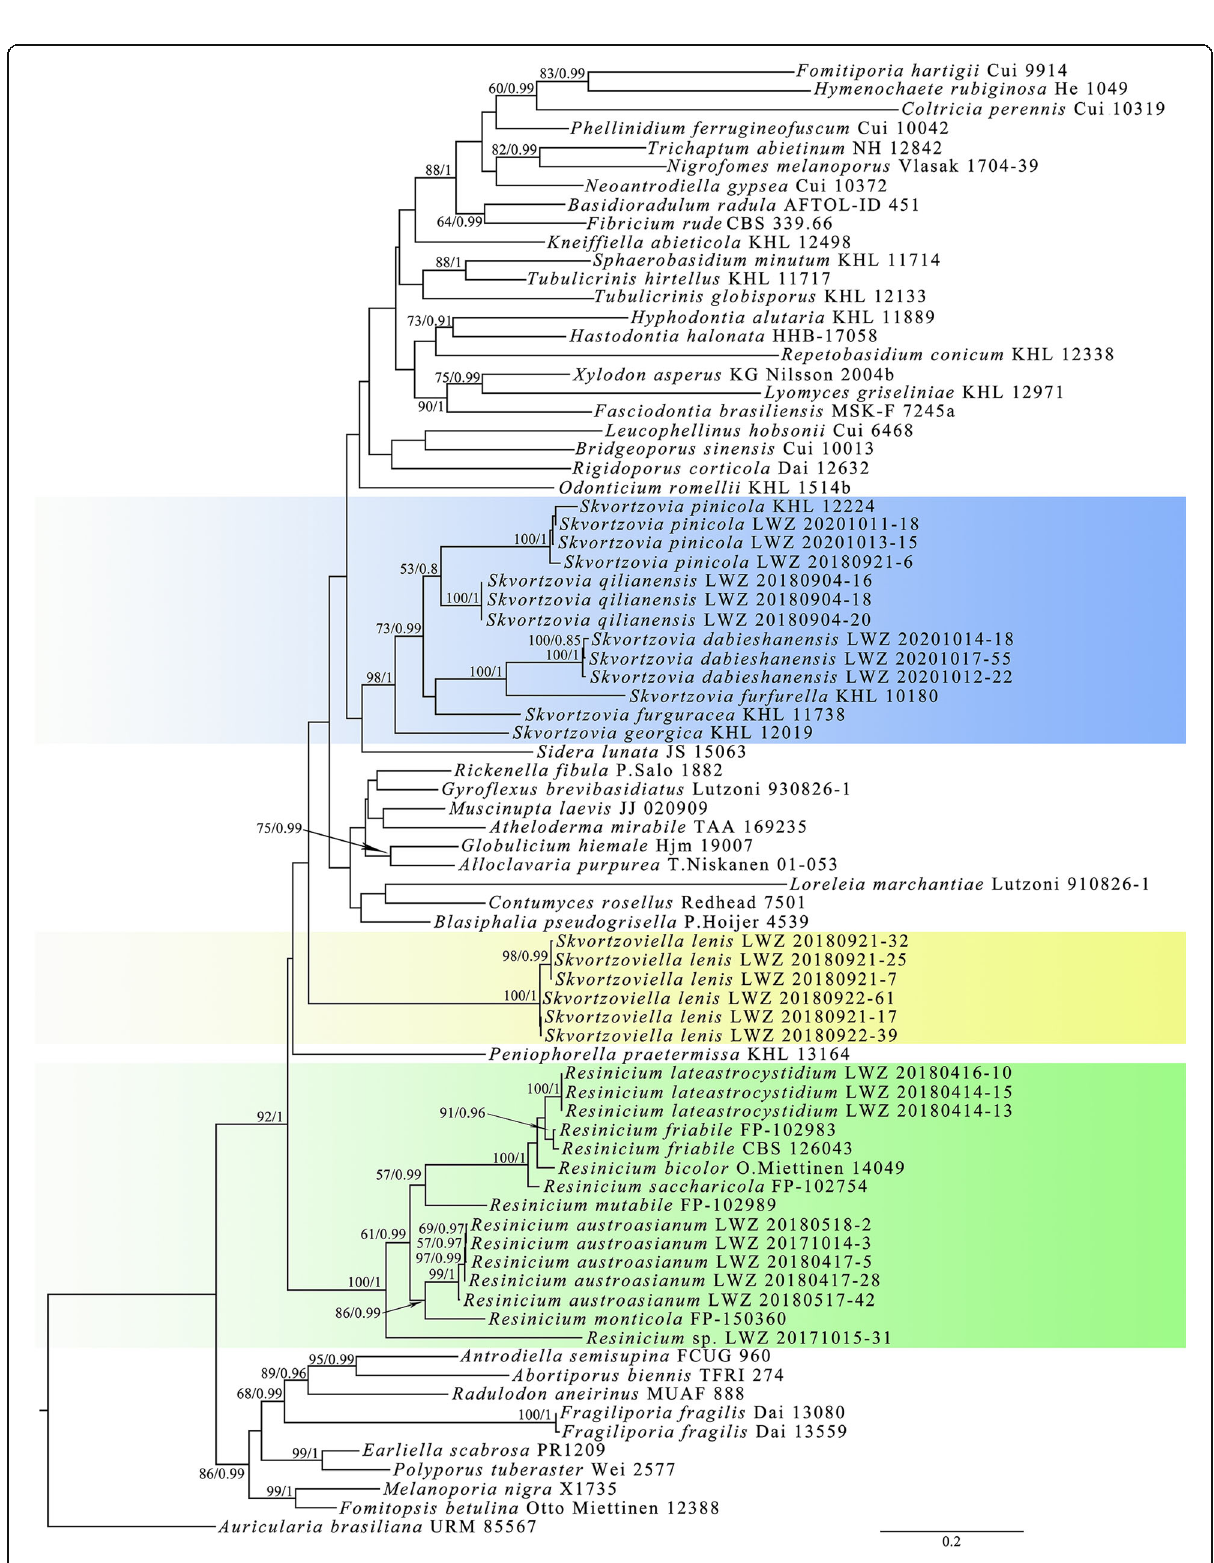
Fig. 1 Phylogenetic positions of the newly studied specimens of Resinicium sensu lato within the Hymenochaetales inferred from the combined dataset of ITS and nLSU regions. The topology generated by the maximum likelihood method is presented along with the bootstrap values and the Bayesian posterior probabilities above 50% and 0.8, respectively, at the